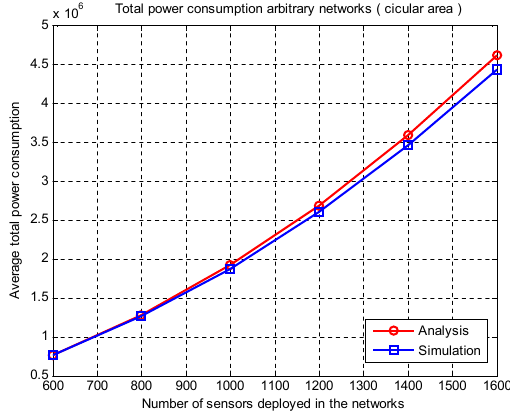
Figure 14. Total power consumption with different number of sensors deployed in a circular sensing area; multi-hop routing is applied to transmit data from each neighborhood to the BS at the center of the sensing area